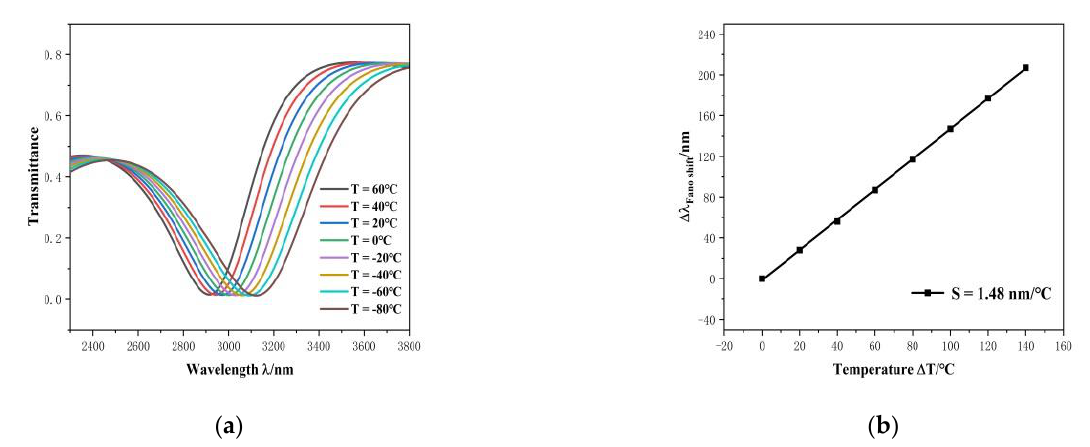
Figure 10. ( a ) Transmission spectrum for the disparate temperatures of the sensor; ( b ) shifts of the dip point in Fano resonance ( Δλ T ) with a changed temperature ( ΔT ).